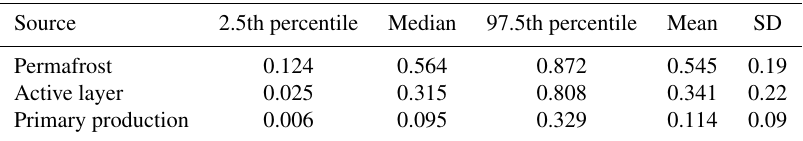
Table 7. Mean relative contribution of three identified sources (source fractions) to the integrated signal at the catchment outlet, using δ 13 C POC for the primary-production